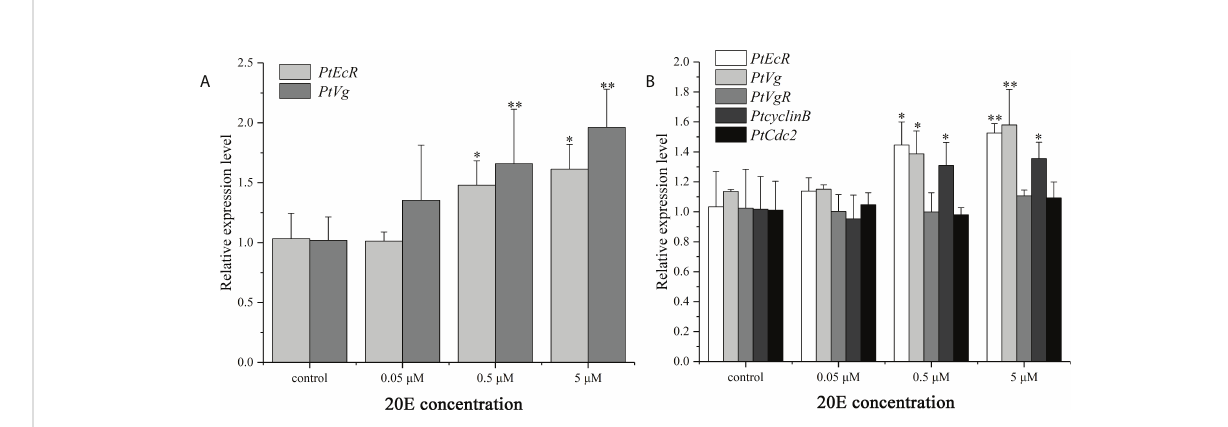
FIGURE 8 In vitro effect of 20E on the expression of PtEcR and PtVg in the hepatopancreas explants (A) , and the expression of PtEcR , PtVg, PtVgR , PtcyclinB , and PtCdc2 in the ovary explants (B) . Data are shown as mean ± SE (n=4). “ * ” represents signi fi cant differences ( P < 0.05) and “ ** ” represents extremely signi fi cant differences ( P < 0.01) from the control